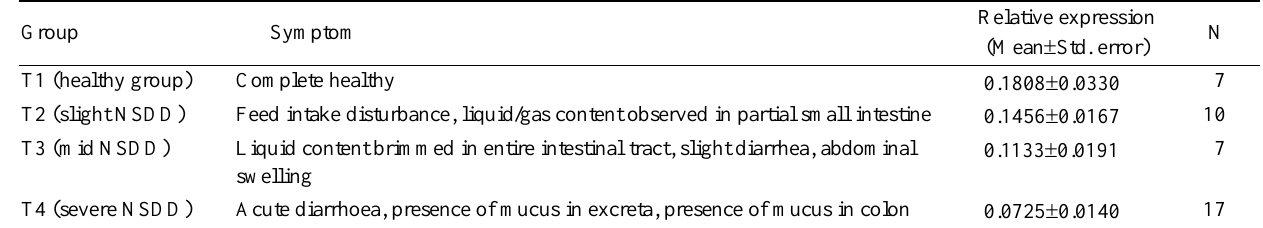
Relative expression N (Mean  Std. error)